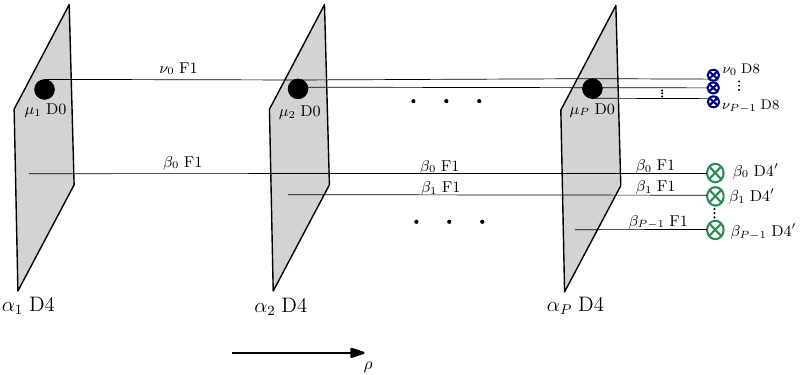
Figure 5. Hanany–Witten brane set-up equivalent to the brane configuration in Table